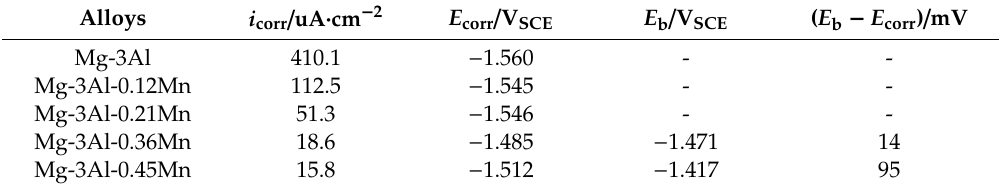
Figure 12. Polarization curves of the Mg-3Al- x Mn alloys in 3.5 wt.% NaCl solution, the breakdown potential E b is marked by the arrow. Table 4. Critical parameters determined from polarization curves for the Mg-3Al- x Mn alloys.